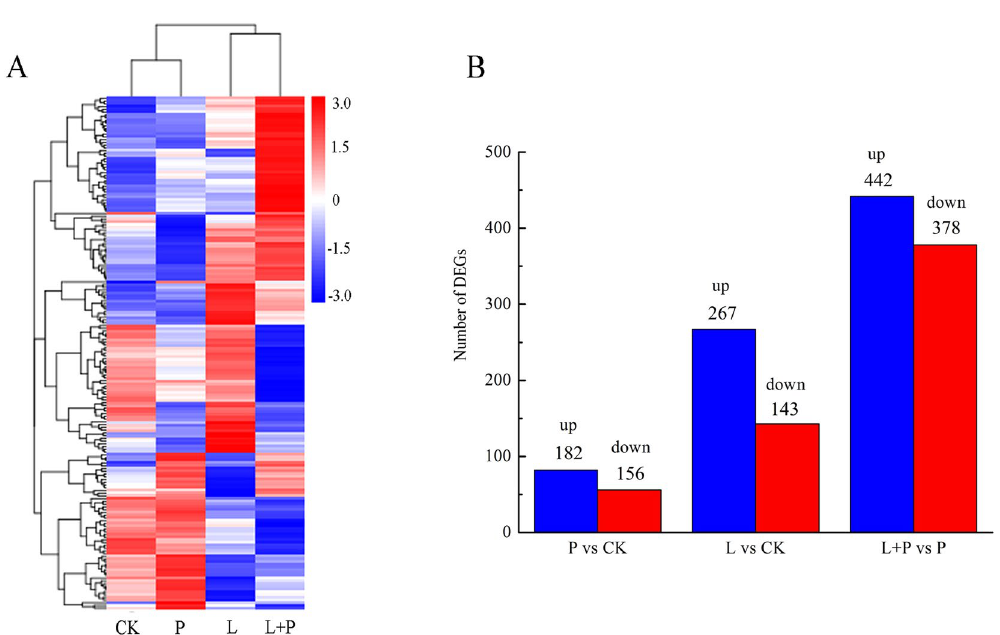
Figure 2. Transcriptome analysis of differentially expressed genes in He-Ne laser pretreated wheat seedlings under drought stress. See notes to Table 1. ( A ) Hierarchical clustering of all the DEGs based on log 10 RPKM (number of reads per kilobase per million clean reads) values. The color (from red to blue) represents gene expression level from high to low. ( B ) Changes in differentially expressed genes (DEG) in He-Ne laser pretreated wheat seedlings under drought stress. The number of up- and down-regulated genes between P and CK, L and CK, and L + P and P are